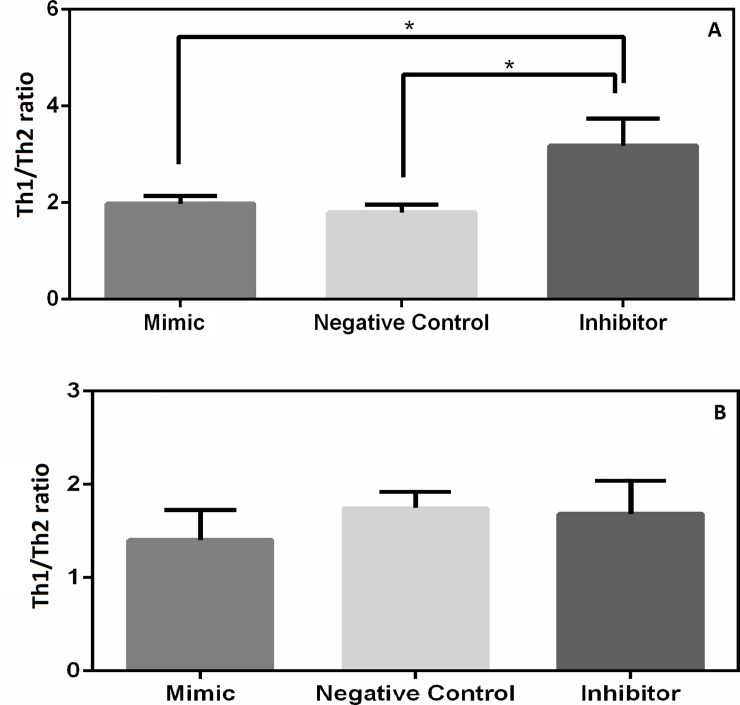
Th1 and Th2 profile.Th1 profile in SL transfected with negative control (scrambled), miR 21 mimic, miR 21 inhibitor and cultured for 67h. (A) SL from dogs with CanL and (B) SL from control non-infected dogs. Data represent the mean values of Th1/Th2 + standard error of the mean. Asterisks represent significance (p<0.05) by Friedman Test with multiple comparison.